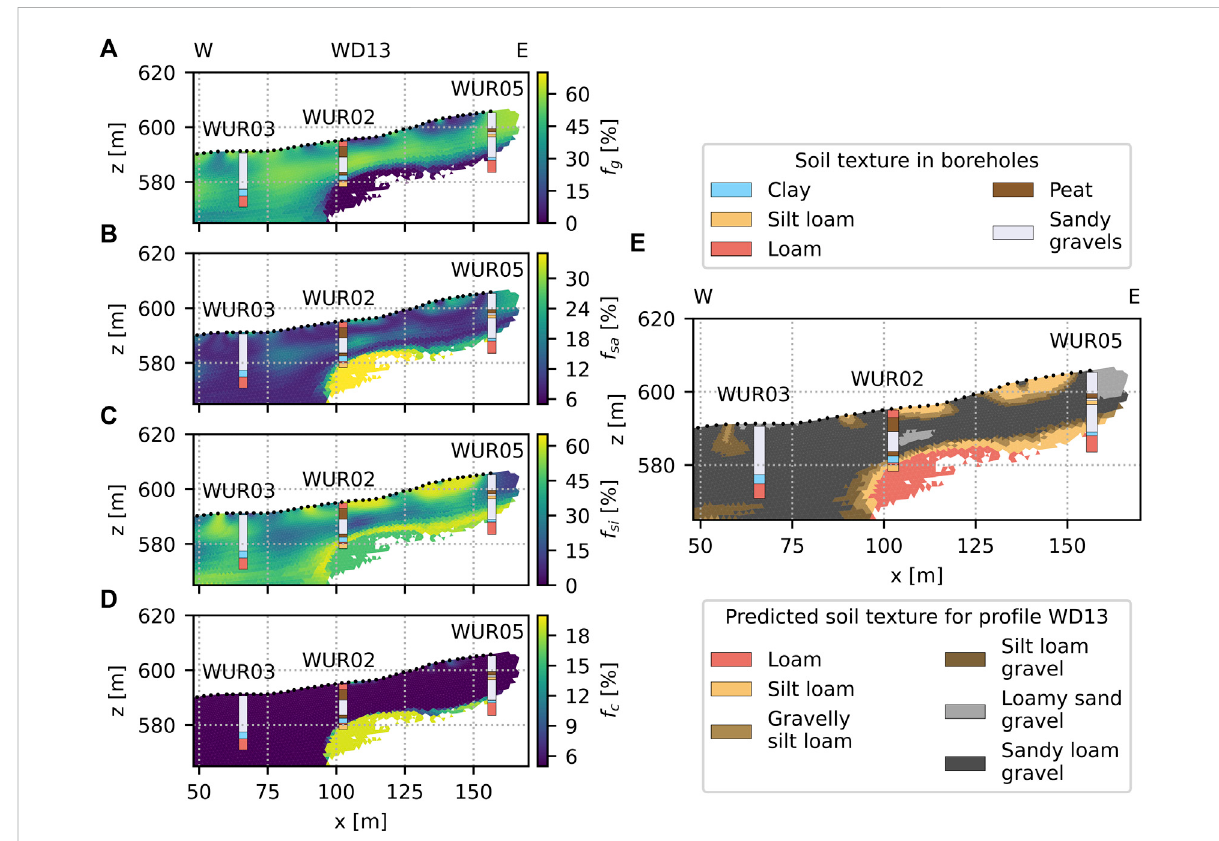
FIGURE 9 Predictedfractionsof (A) gravel( f g ), (B) sand( f sa ), (C) silt( f si )and (D) clay( f c )forthepro fi leWD13and (E) thecorrespondingpredictedsoiltexture with ground-truth information from boreholes WUR02, WUR03 and WUR05 superimposed over each